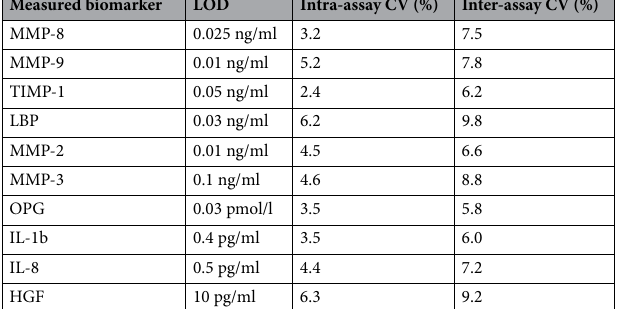
Table 2. Limit of Detection (LOD), intra/inter-assay coefficient of variation (CV) of the examined biomarker ELISA assays.